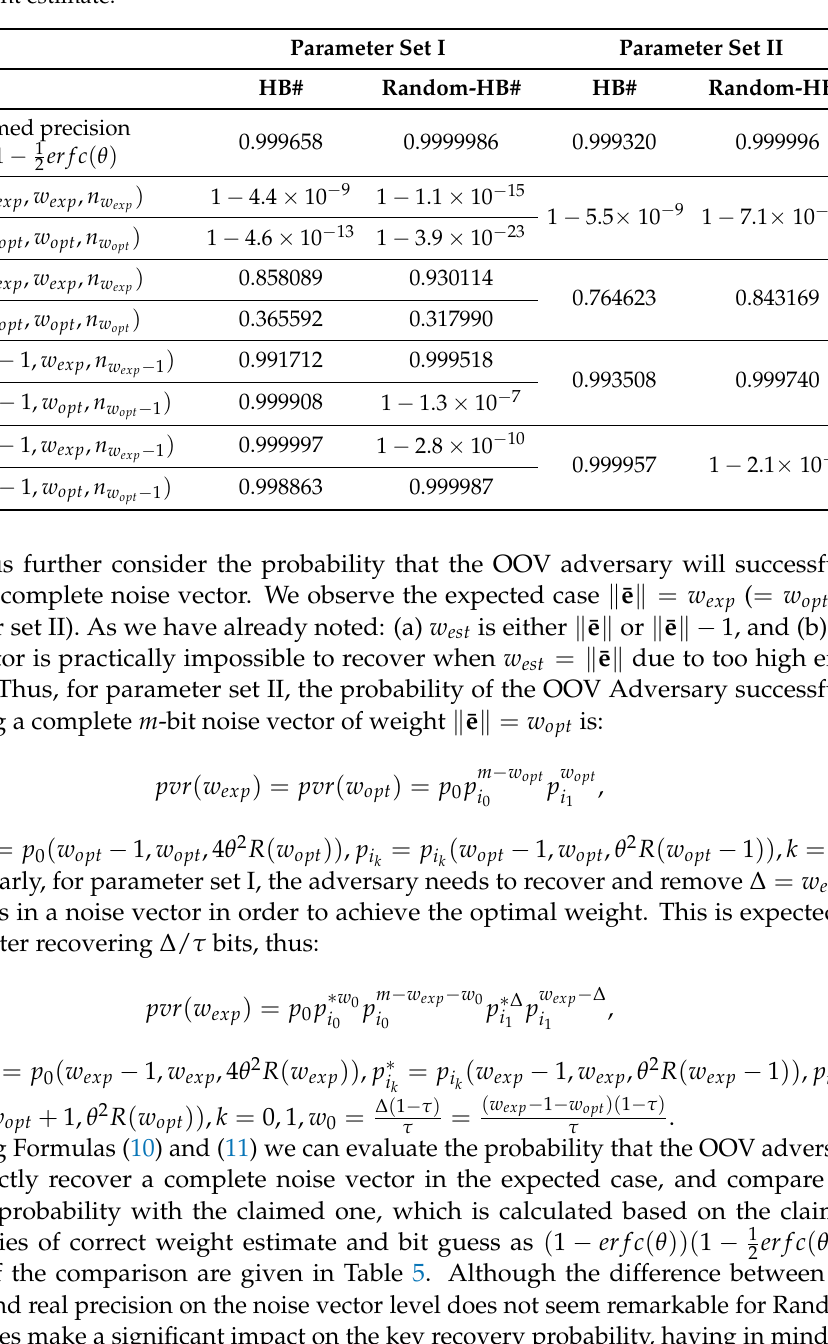
Table 4. Comparison of the claimed and real precision of the OOV bit recovery depending on the initial weight